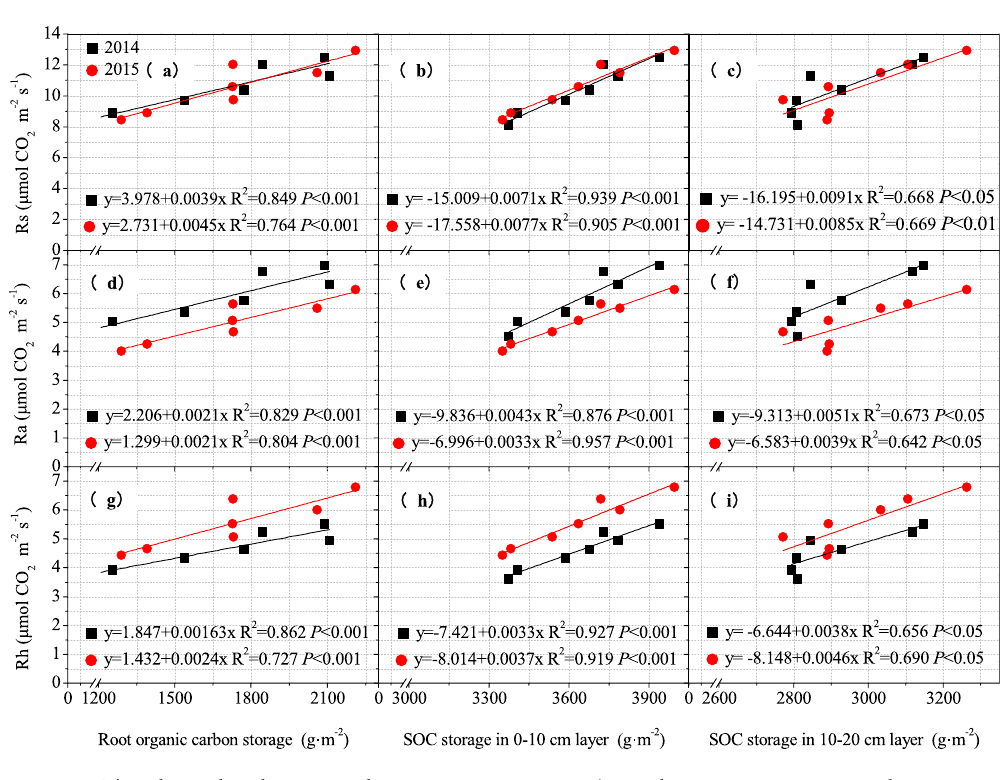
Figure 6. The relationships between soil respiration components (Rs, soil respiration; Ra, autotrophic respiration; Rh, heterotrophic respiration) and organic carbon